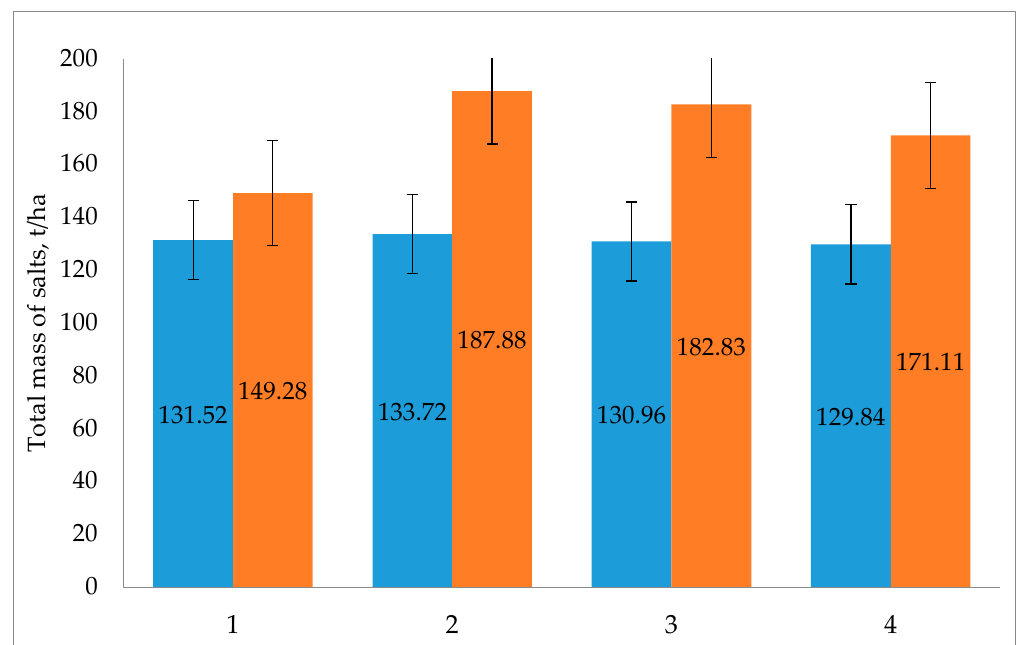
Figure 3. Changes in the total mass of the salts in t/ha in the 0–100 cm soil layer. Row 1: The mass of salts in spring 2016. Row 2: The mass of salts in fall 2018. Note: 1, 2, 3, and 4 represent the treatments.